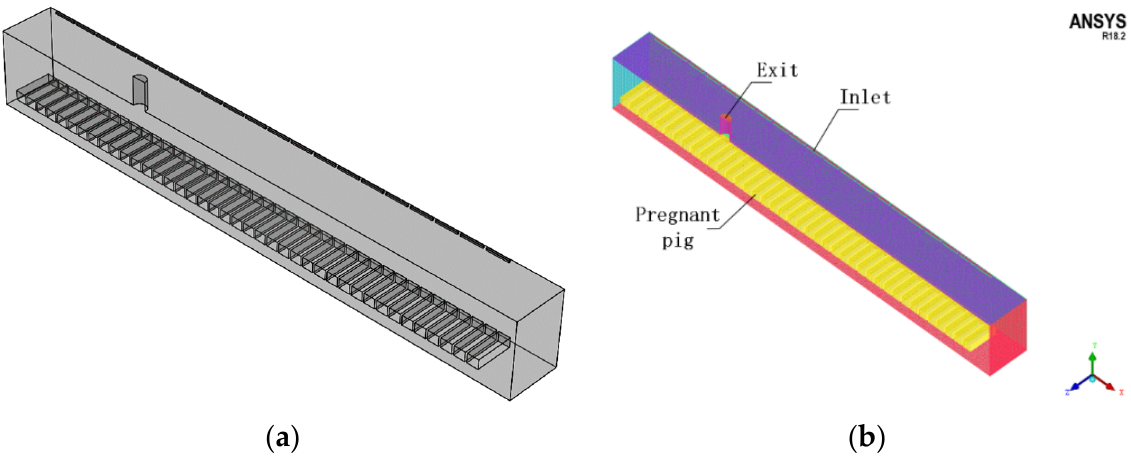
Figure 4. Piggery model: ( a ) piggery model drawing; ( b ) grid model.